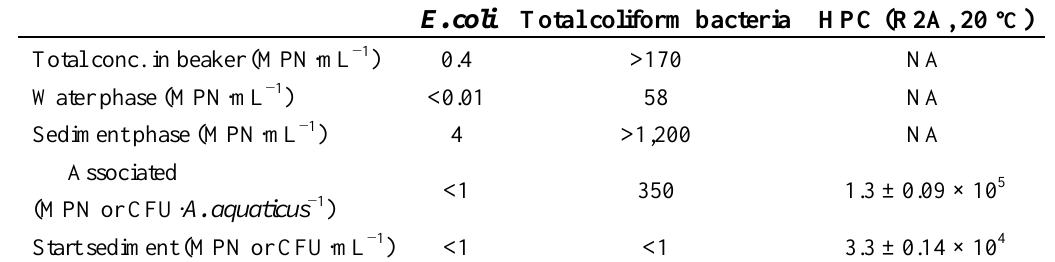
Table 2. Concentrations of bacteria from pond 2 in the beaker with the highest bacterial concentrations (September 2010, see Table 1) after nine weeks incubation. Total concentration in the beaker includes sediment and water